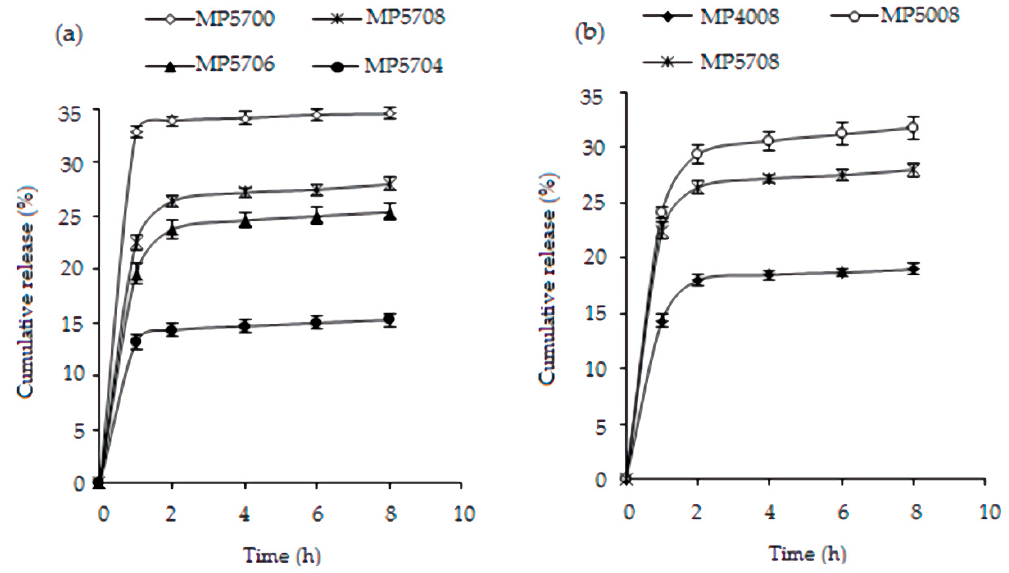
Figure 5. The effect of the chitosan-to-citric acid mass ratio ( a ) and pH value of the polymer stock solution ( b ) on the in vitro cumulative release of bovine serum albumin (BSA) from the non-cross-linked and cross-linked chitosan microparticles.